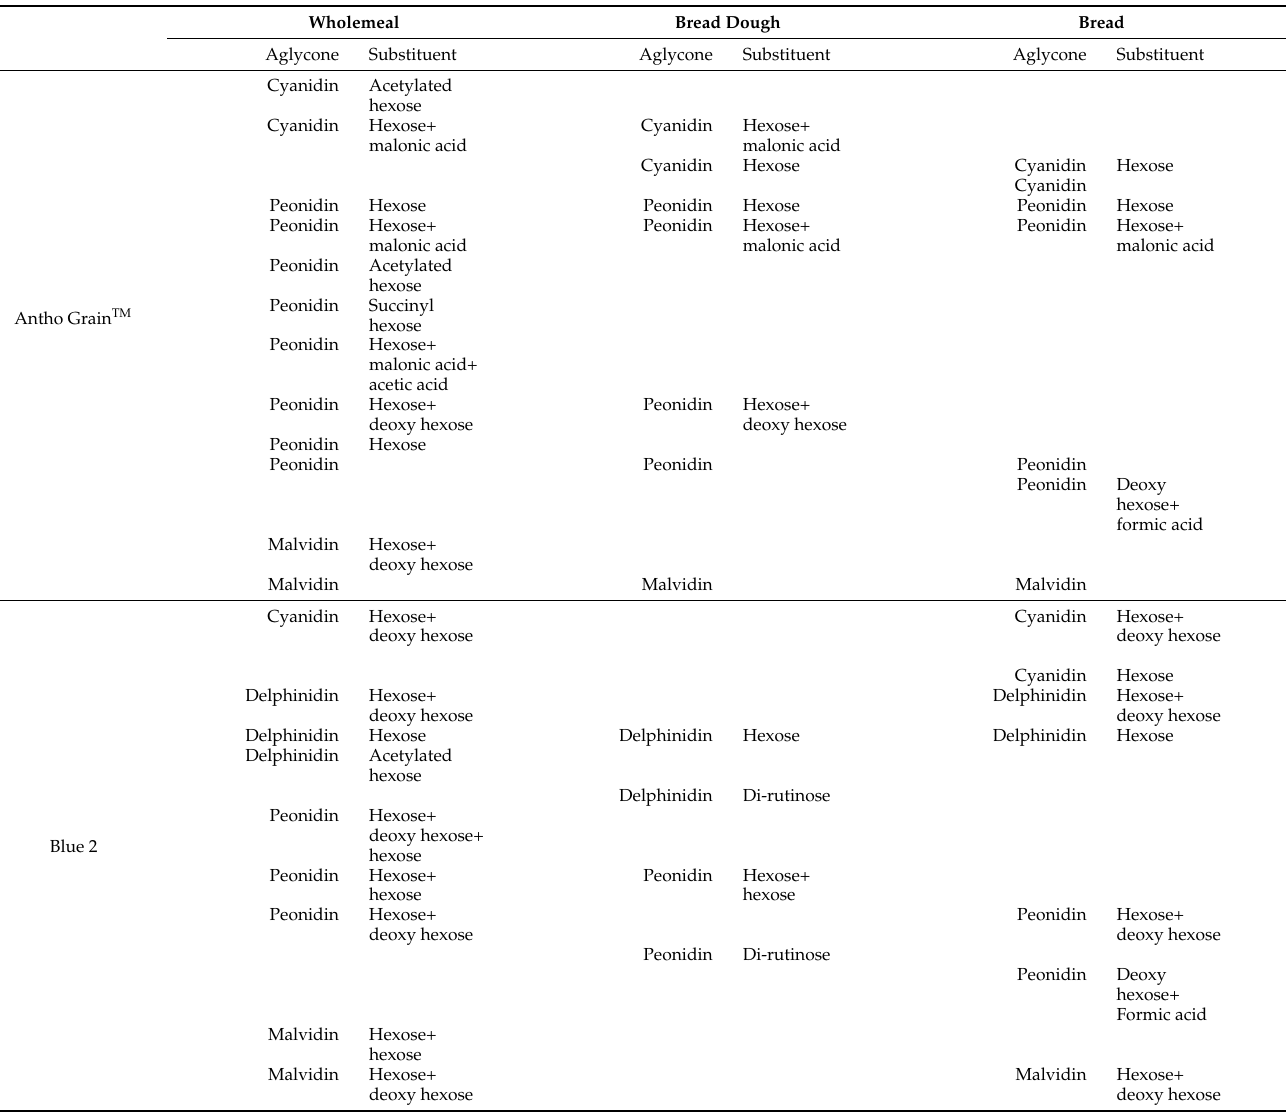
Table 6. Anthocyanin species in AnthoGrain TM and Blue 2 wholemeal, bread dough (77min), and baked bread from LC-MS/MS